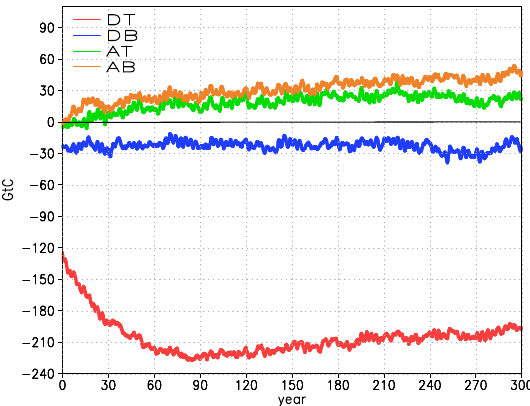
Fig. 5. Evolution of anomalies in global terrestrial carbon in each